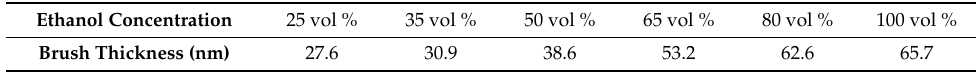
Table A3. Raw data of swollen brush thickness of a PNiPAAm brush plotted in Figure